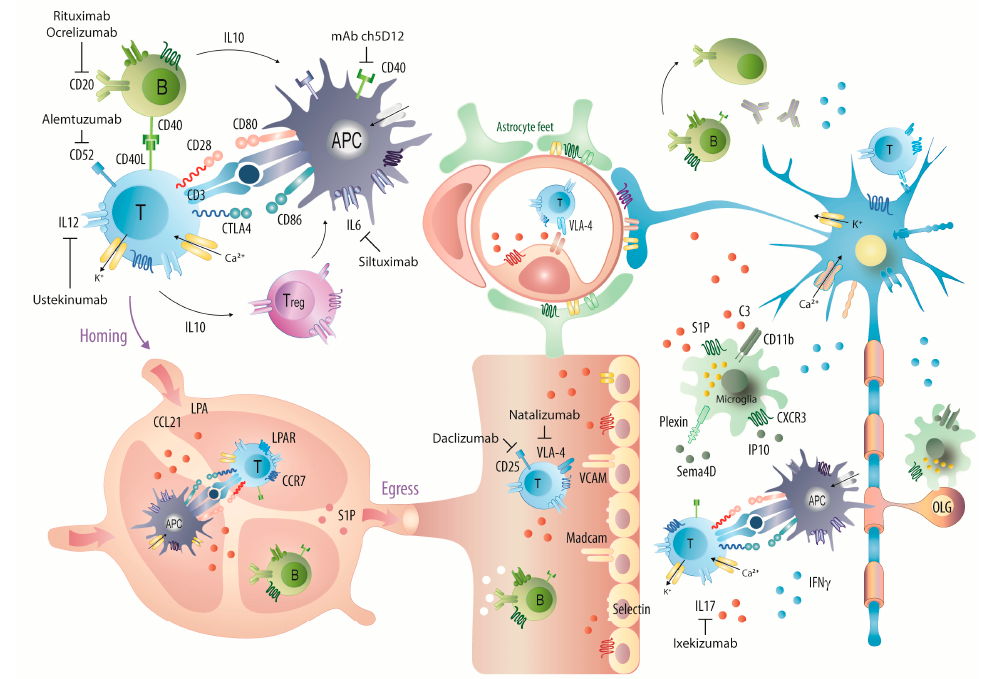
Figure 8. Graphical illustration of the majority of candidates, which were targeted with monoclonal antibodies in EAE studies and mechanisms of some approved mAbs or promising